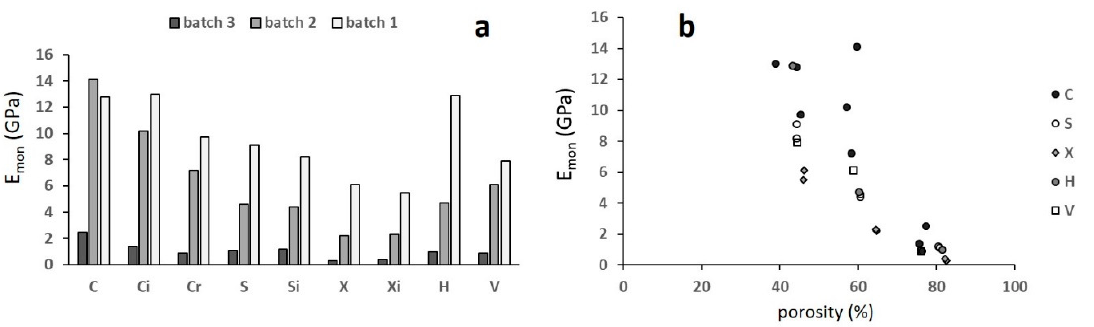
Figure 7. Examples of the compression nominal stress–nominal strain curves. Numbers refer to batches: 1—highest density; 2—intermediate density; 3 lowest density.